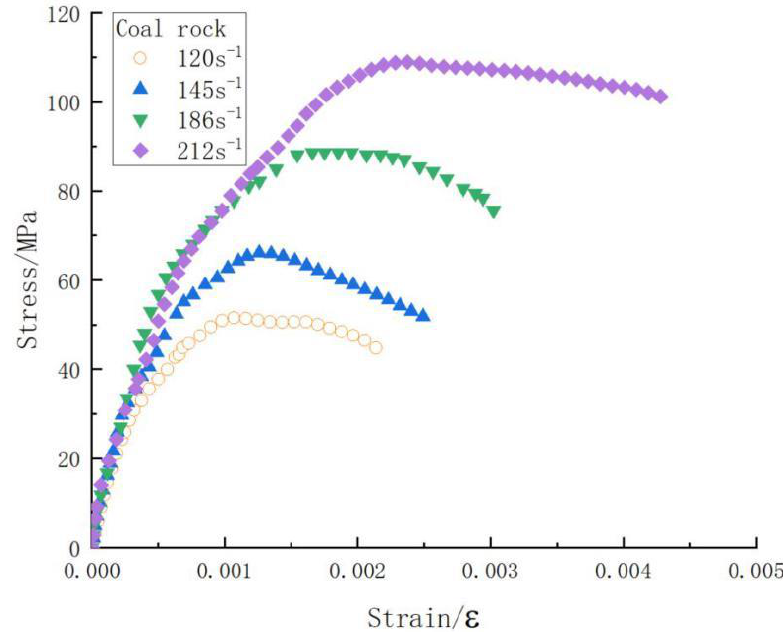
Figure 13. Coal rock stress – strain curve.